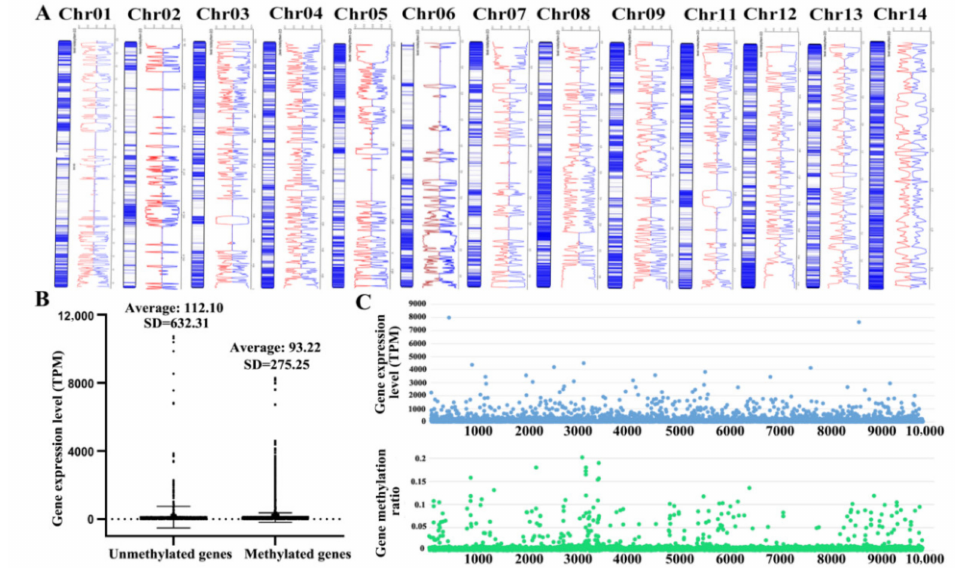
Figure 4. Methylation of transposon and genes, and the relationship of the methylation ratio and gene expression level. ( A ) Transposon location and methylation; ( B ) Gene expression level of methylated and unmethylated genes; ( C ) Methylation ratio and gene expression